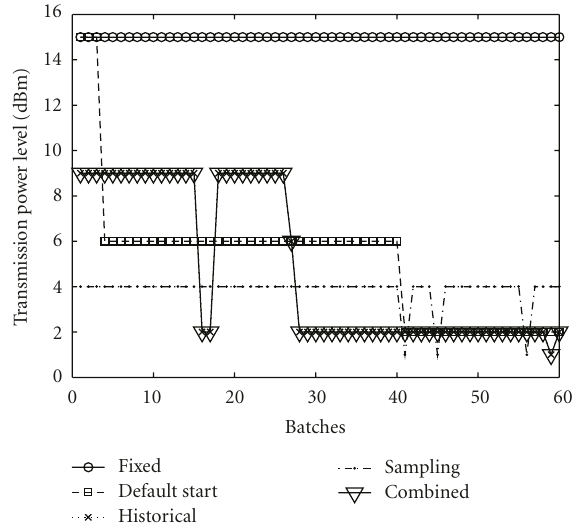
Figure 4: The selected best power level in each time interval by di ff erent methods in scenario 1 (IEEE 802.11).